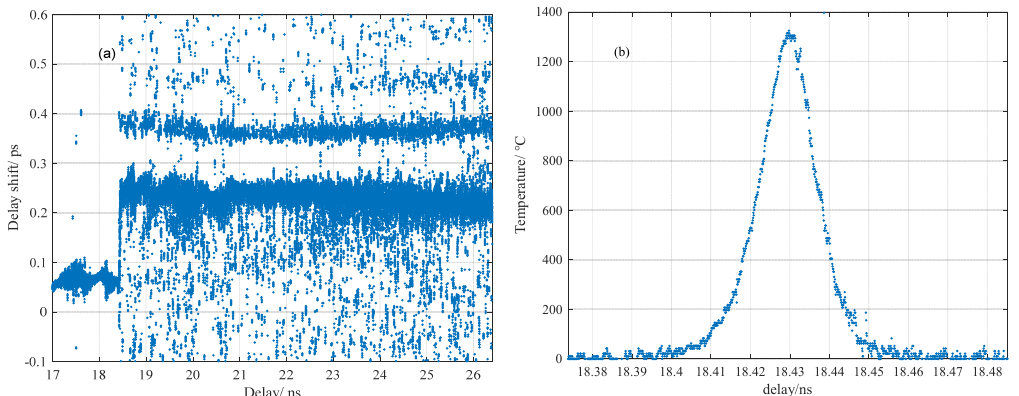
Figure 7. ( a ) Multiple delay shifts corresponding to the ( b ) converted temperature distribution biased from the heating center.